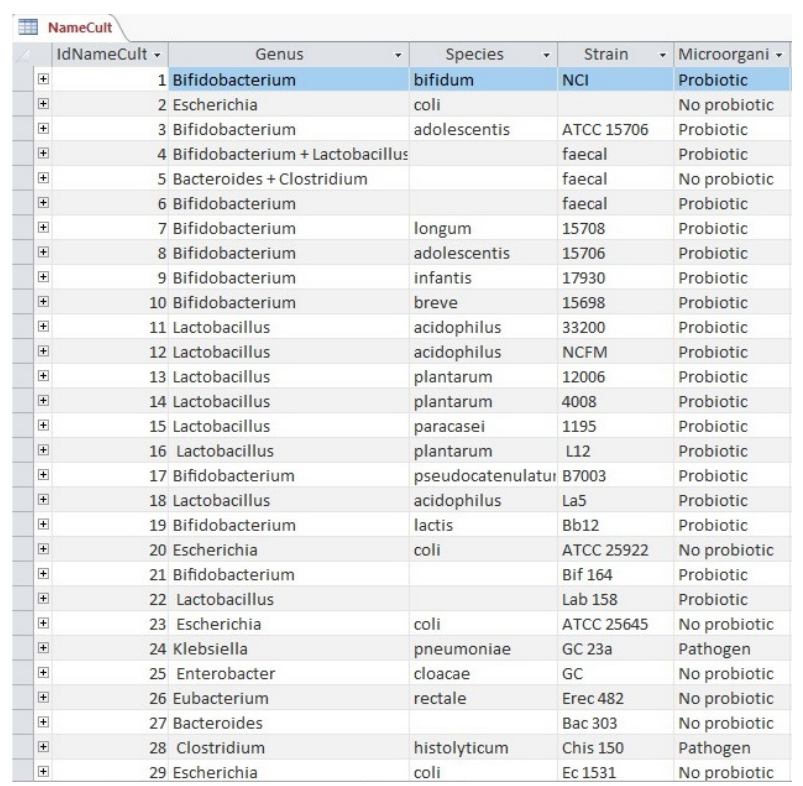
Figure 3. Table «Prebio» containing the key data on prebiotics-substance, source of origin, and information about manufacturer. The cell “Commercial” was filled by value “no” if new, non traditional sources of prebiotics was applied in the researches. This should help the users to recognize the features of some plants.